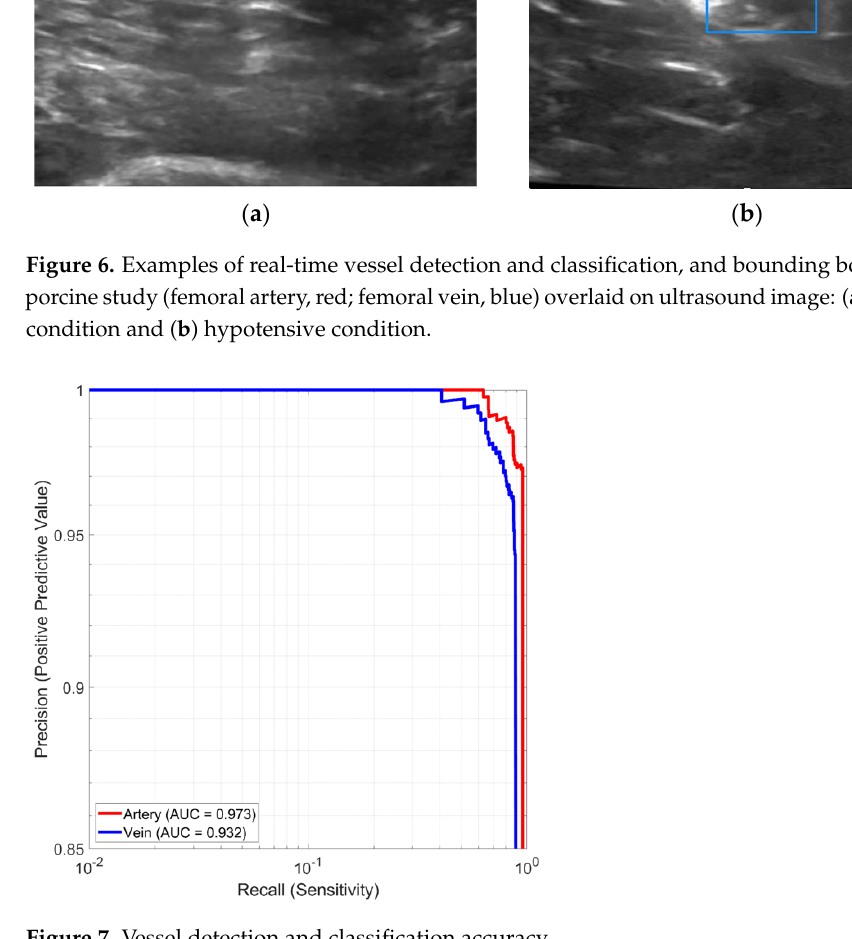
Figure 6. Examples of real-time vessel detection and classification, and bounding box placement in porcine study (femoral artery, red; femoral vein, blue) overlaid on ultrasound image: ( a ) normoten- sive condition and ( b ) hypotensive condition.